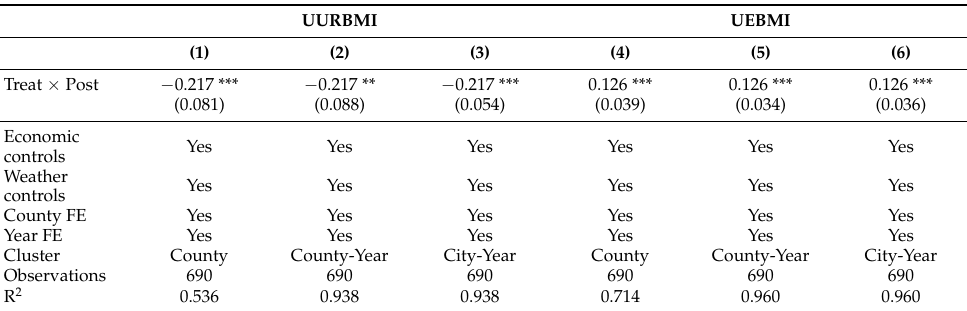
Table 3. Impact of the SPR on medical expenses: by insurance